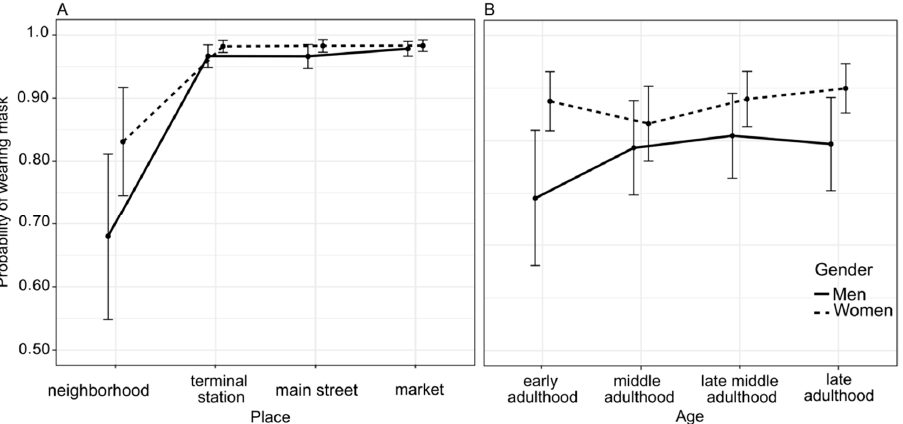
Figure 2. Wearing mask probability during the COVID-19 pandemic. ( A ) Interaction plot showing the probability of face mask-wearing between genders at different public areas, and ( B ) the probability of wearing masks between gender at different ages. The probabilities were estimated from a binomial GLMM across observations ( n = 36,441). Error bars represent the standard error of the mean.